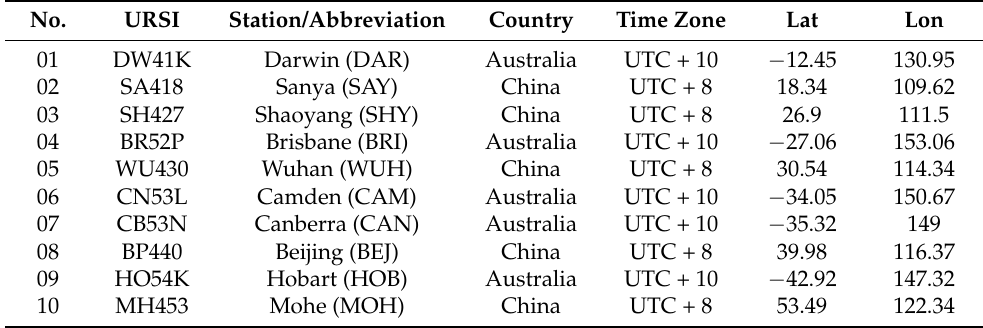
Table 1. Geographic coordinates and details of the ionosonde stations.